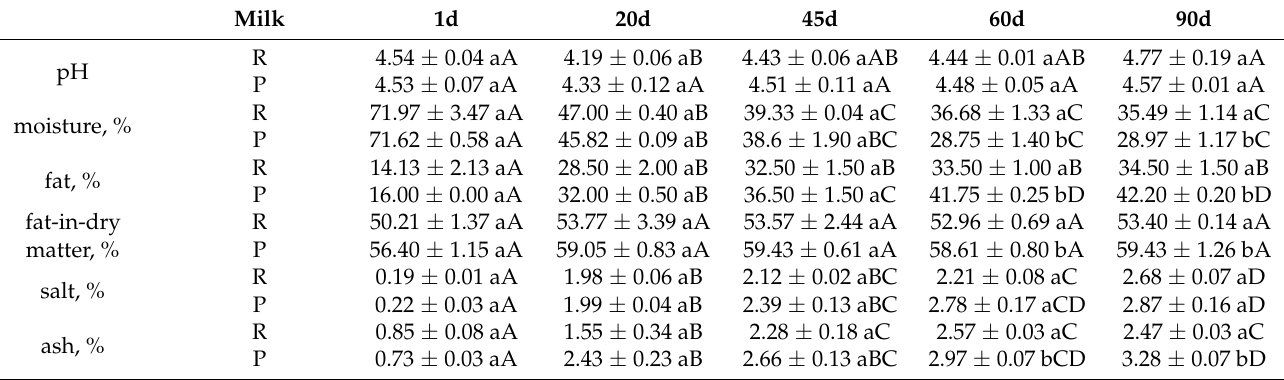
Table 2. Physicochemical characteristics of hard Xinotyri cheese made from raw (R) or pasteurized (P) milk, during ripening and storage (i)